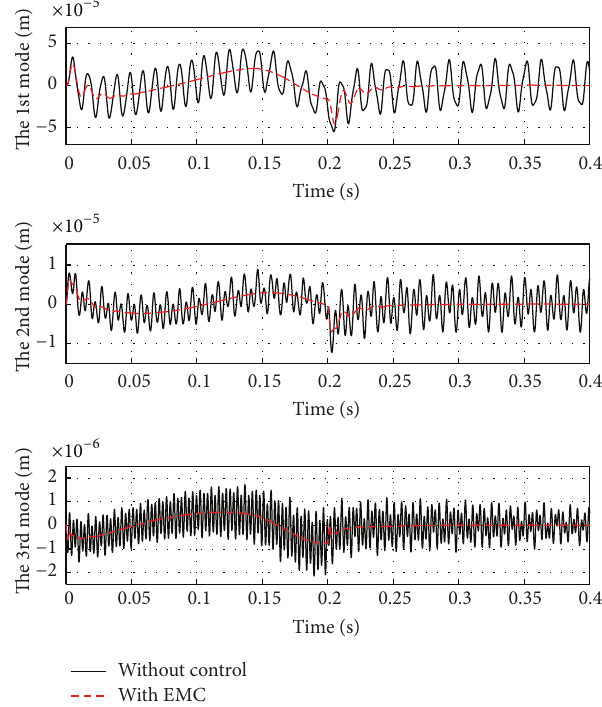
Figure 6: The first three mode vibrations at the three quarters of the first flexible link.